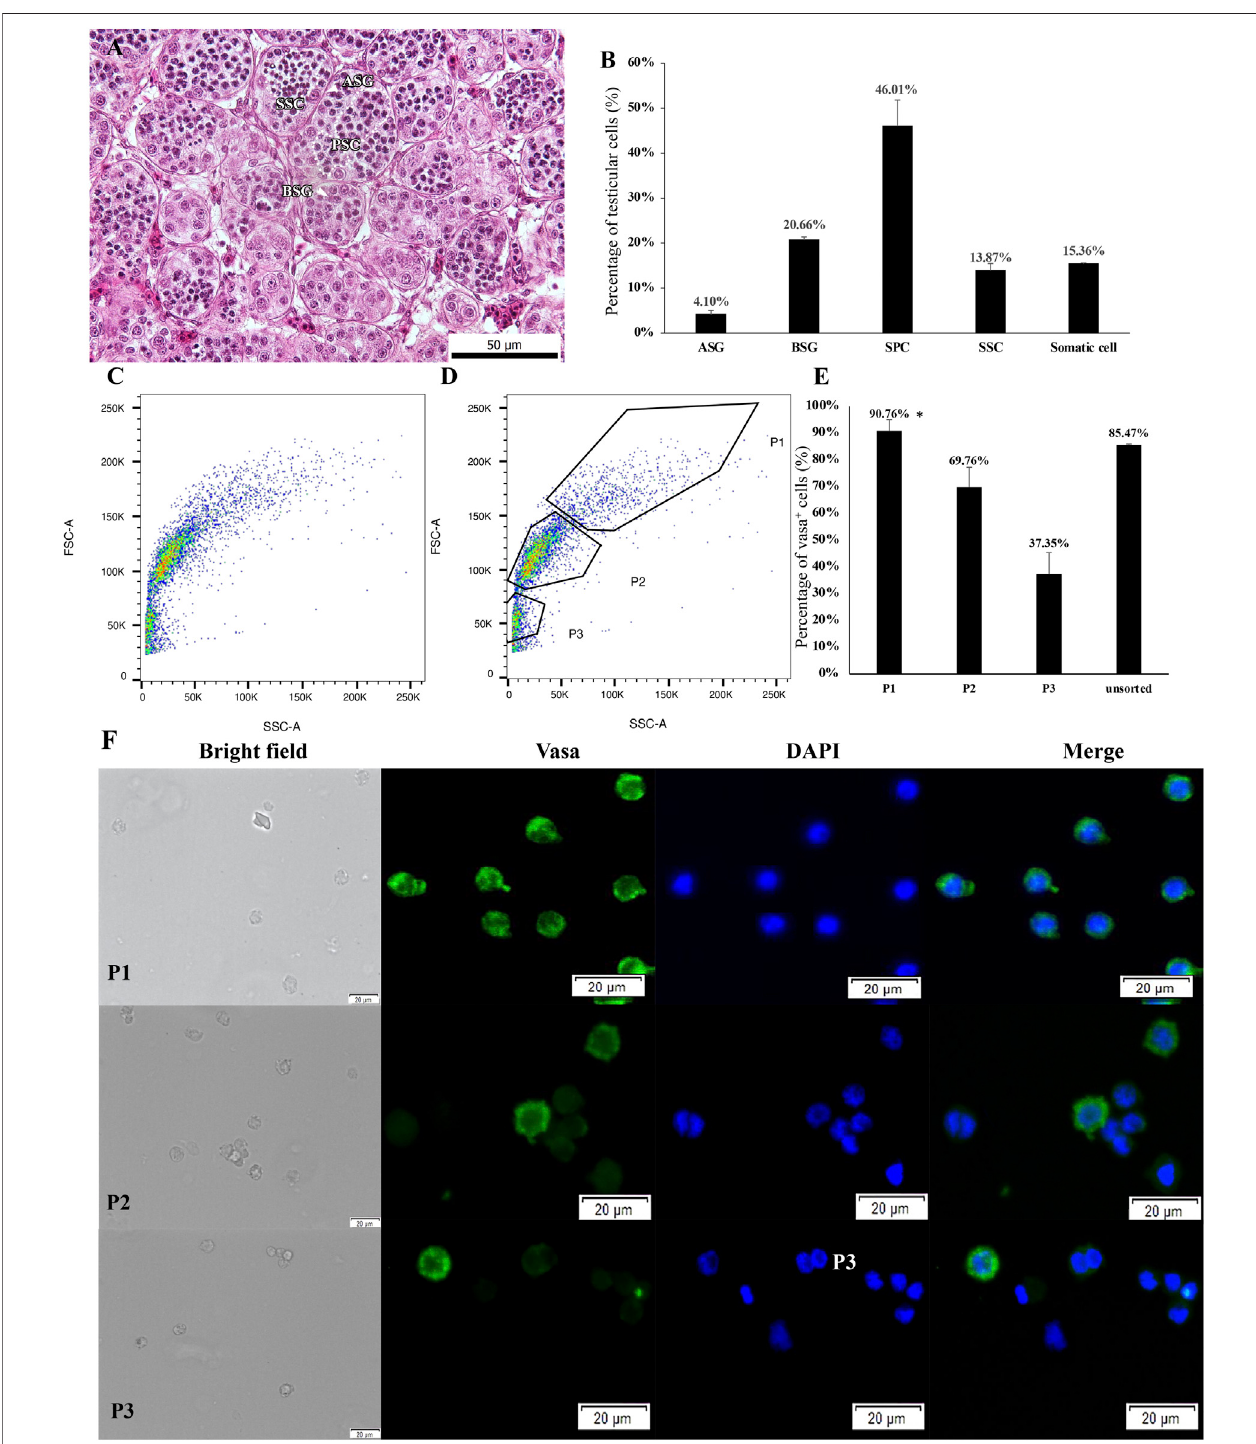
FIGURE3| Histologicalobservationandlightscatteringproperty-dependentfractionationof2 year-oldsterlettestes. (A) Testessectionsstainedwithhematoxylin and eosin (HE). (B) The proportion of various germ cell populations and somatic cells in testes. ASG, type A spermatogonia; BSG, type B spermatogonia; SPC, primary spermatocyte; SSC, secondary spermatocyte. (C, D) Bivariate histograms of fl ow cytometry data from dissociated testicular cells prepared from 2 year-old sterlets. Gates P1 – P3 were set on the histogram and used for cell sorting. (E) Vasa-positive rates of sorted cells in gates P1 – P3 and unsorted live cells [mean ± standard error of mean (SEM)]. Means with an asterisk indicate a signi fi cant difference (n (cid:1) 5, p < 0.05). (F) Microscopic observation of sorted cells using gates P1 – P3. (G) Cells from gates P1-P3 stained with anti-vasa antibody and DAPI.